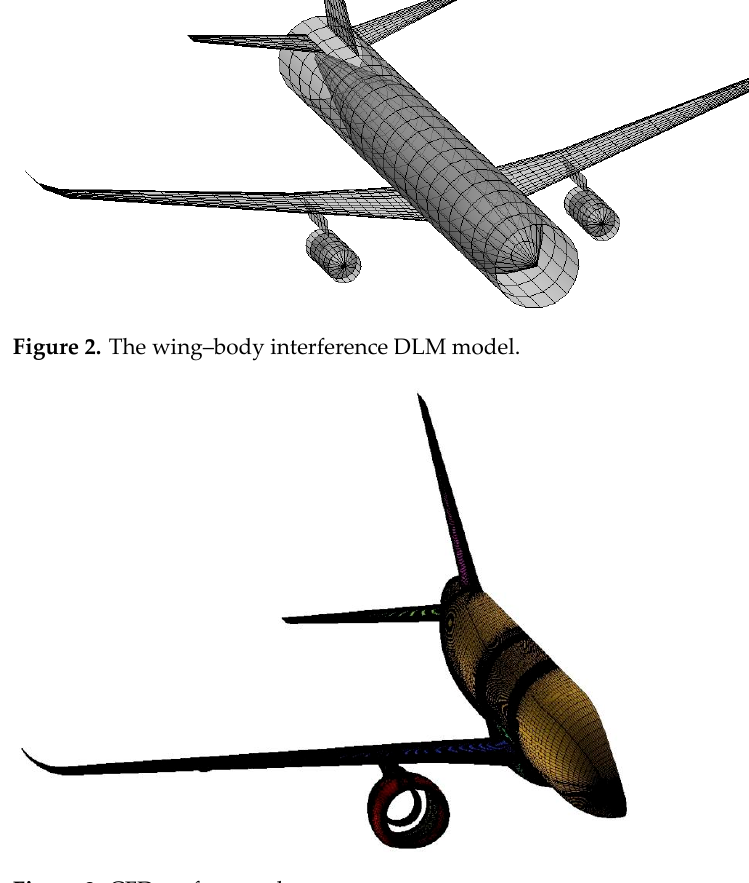
Figure 3. CFD surface mesh. Table 3. CFD grid details. Table 2. Number of elements for the wing–body interference DLM model.